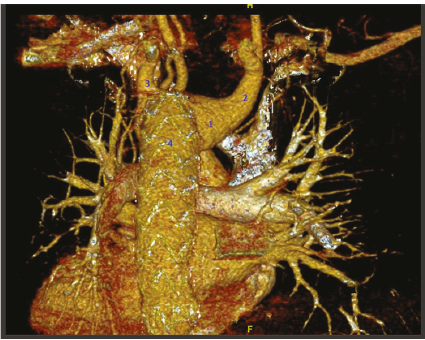
Figure 5: Postoperative CT aorta 3D reconstruction posterior view showing Kommerell ’ s diverticulum (1), patent right aberrant subclavian artery (2), left subclavian artery (3), and a stent inside the descending aorta